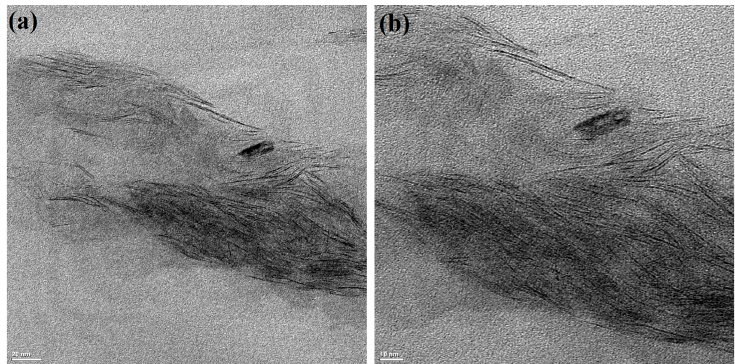
Figure 5. TEM micrographs of PBT/Clay nanocomposite content with 3.7 wt% of MBClay ( a ) low magnification and ( b ) high magnification.